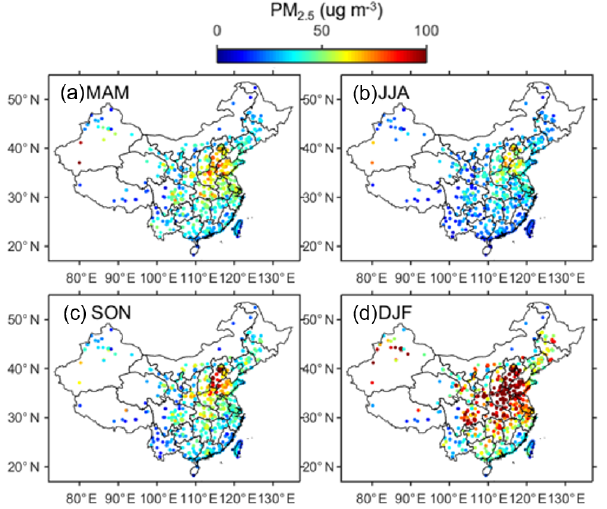
Figure 5. The relationship between CALIPSO-derived PBLH and early-afternoon PM 2 . 5 over (a) the NCP, (b) the PRD, (c) the YRD, and (d) NEC. The black dots and whiskers represent the average values and standard deviations for each bin. The red dashed lines indicate the regular linear regressions, and the black lines represent the inverse fit ( f (x) = A/x + B ). The detailed fitting functions are given at the top of each panels, along with the Pearson correlation coefficient (red) and the correlation coefficient for the inverse fit (black). Here and in the following analysis, R with asterisks indi- cates that the correlation is statistically significant at the 99% con- fidence level. The color-shaded dots indicate the normalized sample